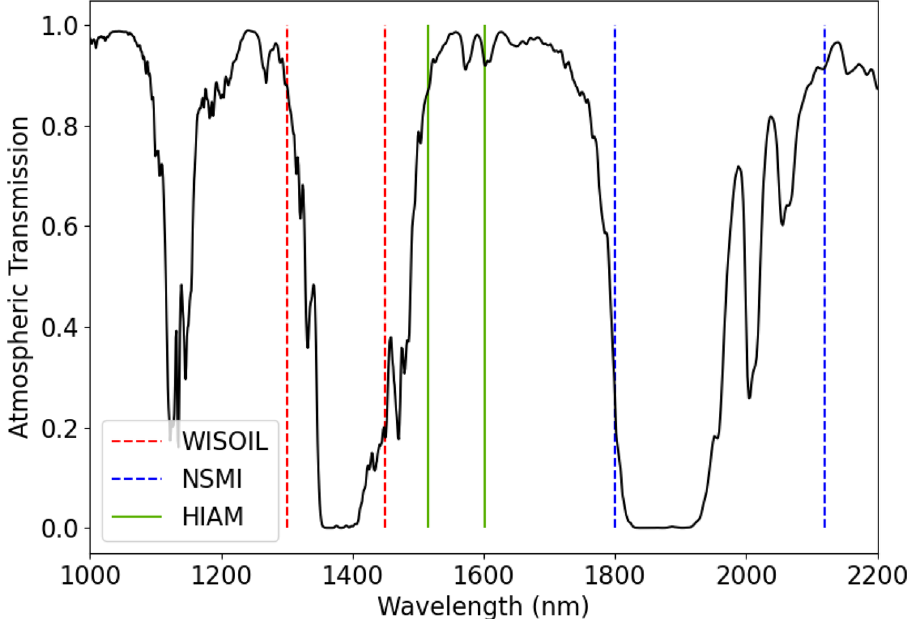
Figure 8. Wavelengths comprising existing indices WISOIL and NSMI, along with the index proposed in this work, imposed on atmospheric transmission spectrum computed using LOWTRAN 22